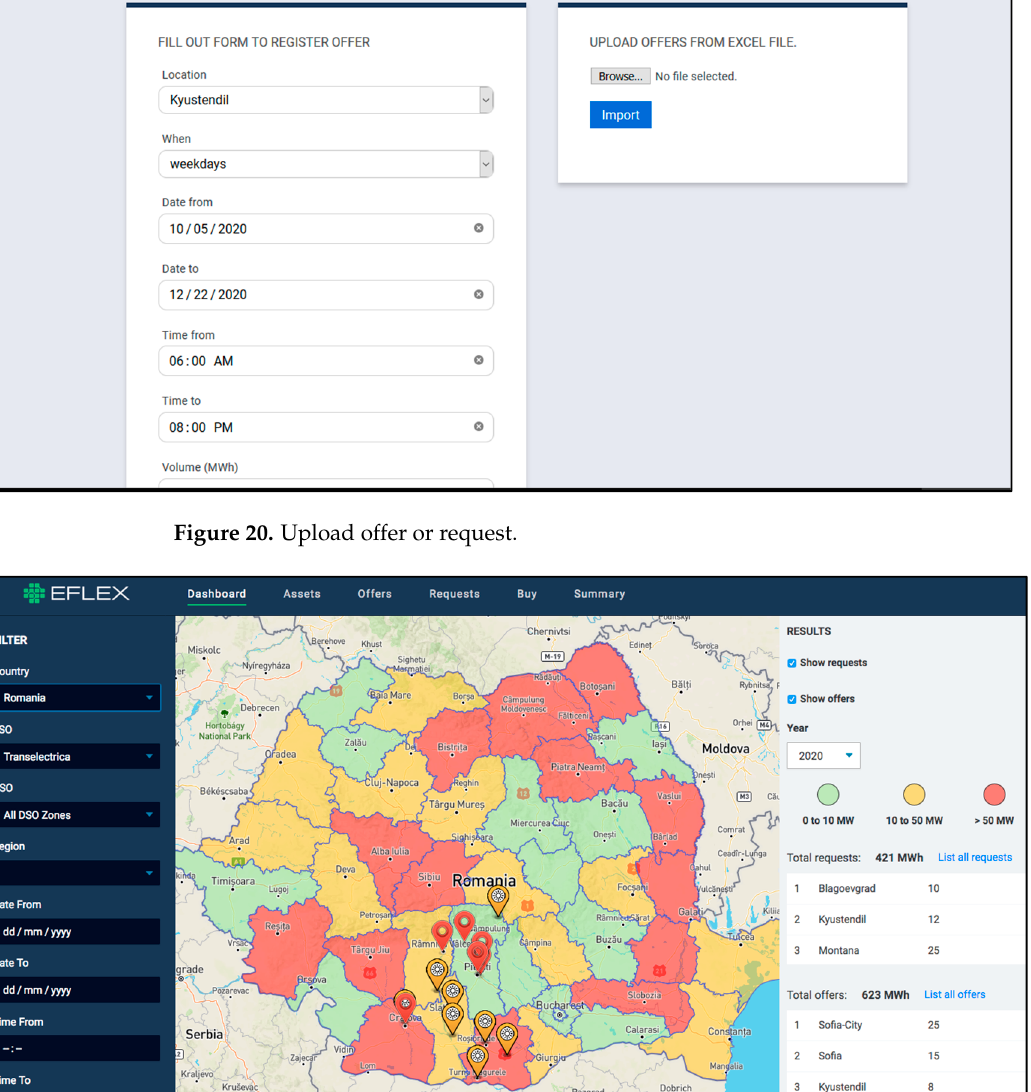
Figure 22. Blockchain-based wallets to facilitate micro-payments between buyers and sellers. After the transaction is successful, the DSO/TSO wallet balance will be debited, and the corresponding flexibility service providers’ (FSPs) wallet balance will be credited.